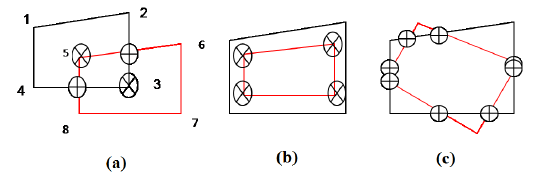
Figure 2: Intersection area calculation for vector polygons in 2D.